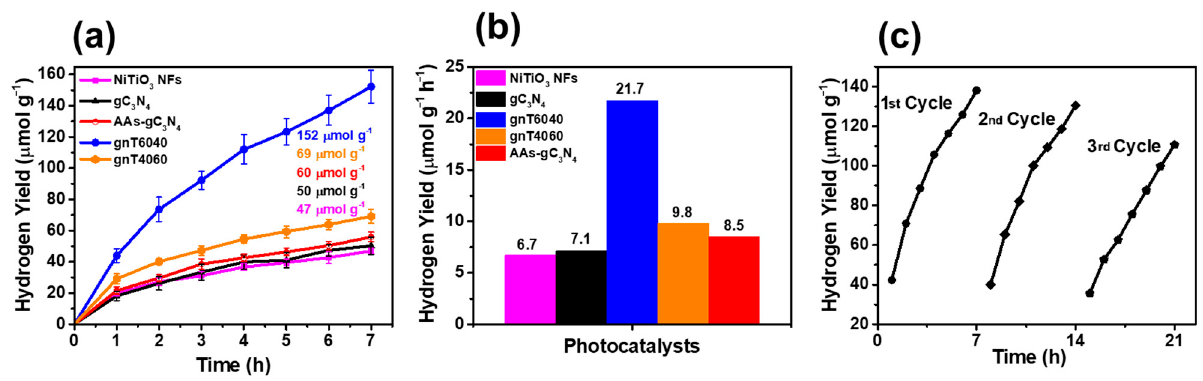
Figure 8. Photocatalytic H 2 evolution results measured in ( a ) μ mol g − 1 and ( b ) μ mol g − 1 h − 1 . ( c ) Reusability evaluation of gnT6040.